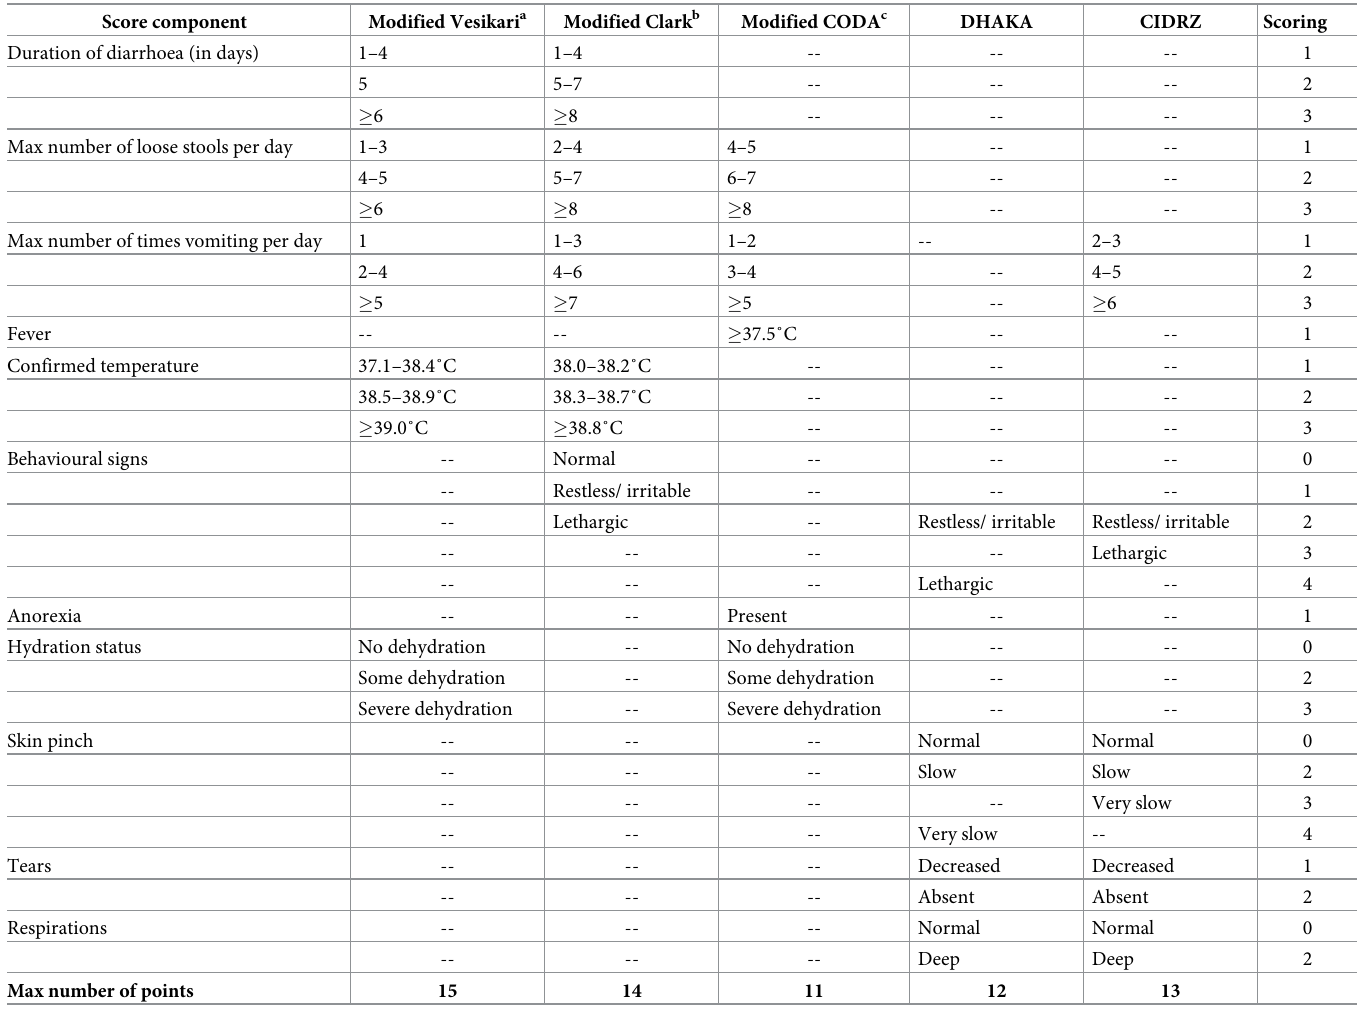
Table 1. Vesikari, Clark, CODA, DHAKA, and CIDRZ